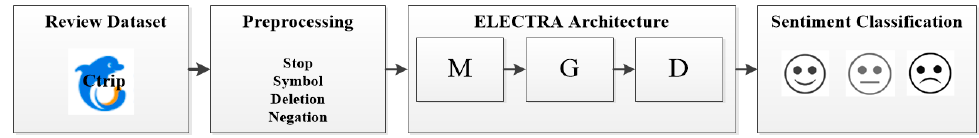
Figure 1. Pipeline overview. M is short for mask operation, and G and D are the generator and discriminator, respectively.